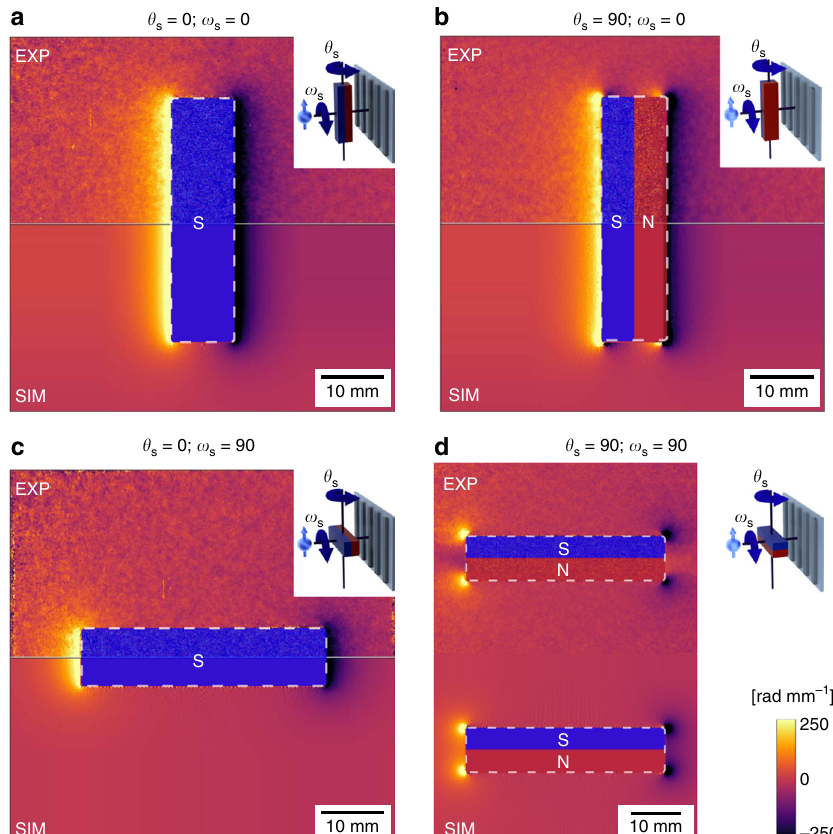
Fig. 7 Experimental and calculated differential phase contrast image (DPCI) results of an inhomogeneous and anisotropic magnetic fi eld. a – d Merged DPCI images of a rectangular cuboid neodymium permanent magnet. The insets in the upper right corners display the four different orientations of the permanent magnet according to the θ s rotation rotation angle around the vertical axis as fi rst, then the ω s around the horizontal axis and keeping the gratings oriented parallel to the initial polarization according to the con fi guration ω = 0 of the homogeneous, well-de fi ned, square-shaped, and uniaxial magnetic fi eld. The four DPCI images are merged along the horizontal axis in order to aid the comparison between the experimental and the calculated data. The top halves have been retrieved from the experimental results, while the bottom ones have been calculated one from the fi nite element method (FEM) simulations. The dashed line represents the edges of the permanent magnet